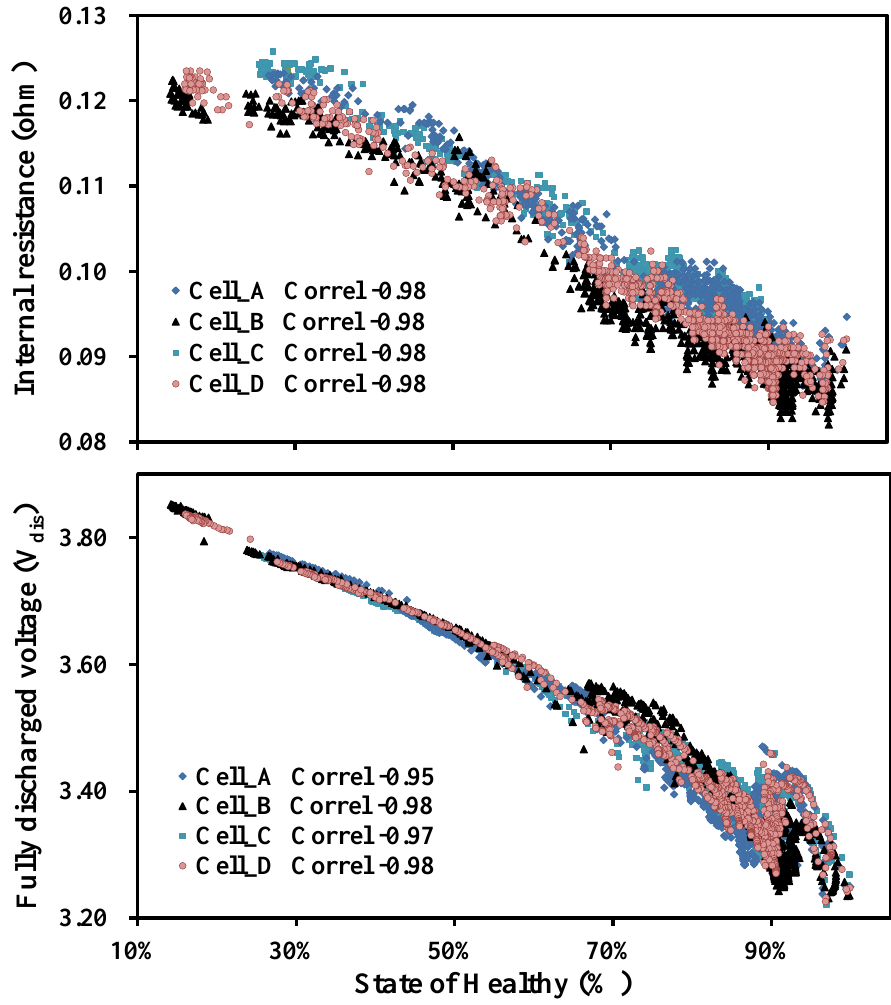
Figure 5. Correlations of SOH and aging parameters (N, R, and V dis ) for four batteries.